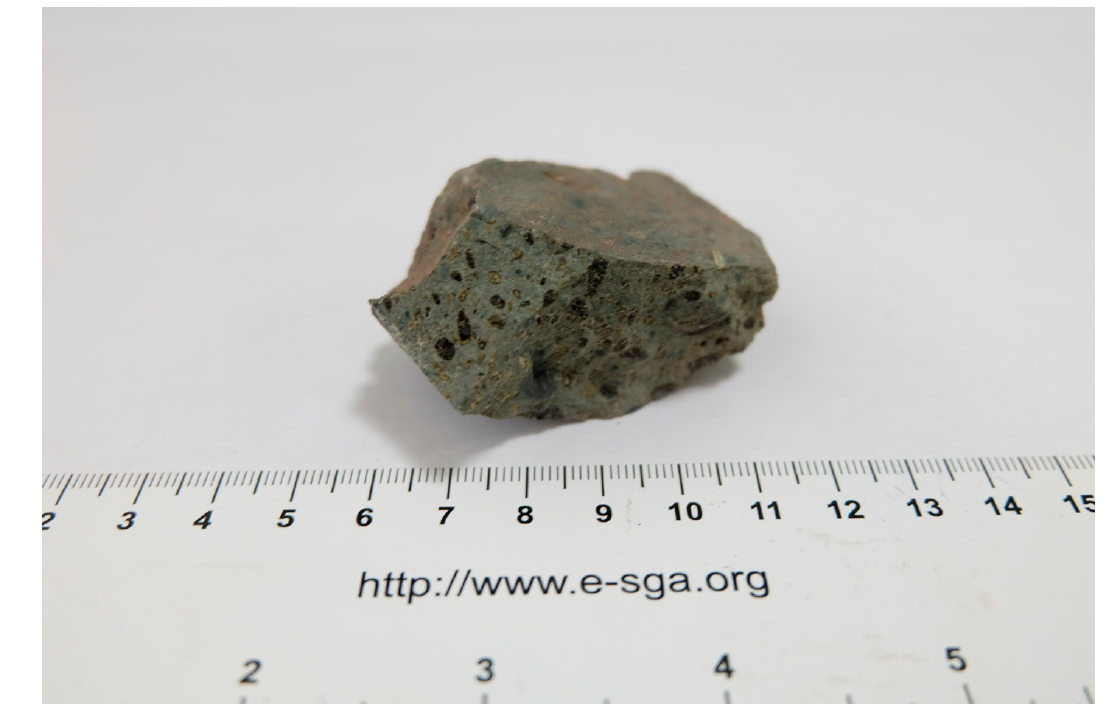
Figure A6. Autolithic breccia (sample ID 37CA_13), Vent Facies Kimberlites (diatreme), Upper Devonian—Middle Carboniferous ( iD 3 -C 2 ), Arkhangelskaya pipe.